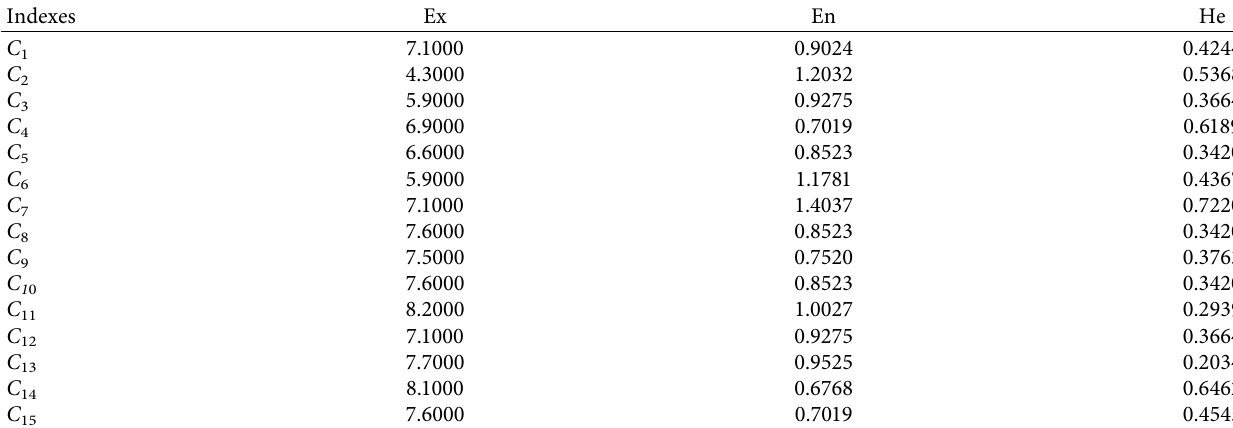
Table 6: Cloud digital characteristics of comprehensive ability evaluation index for accounting applied